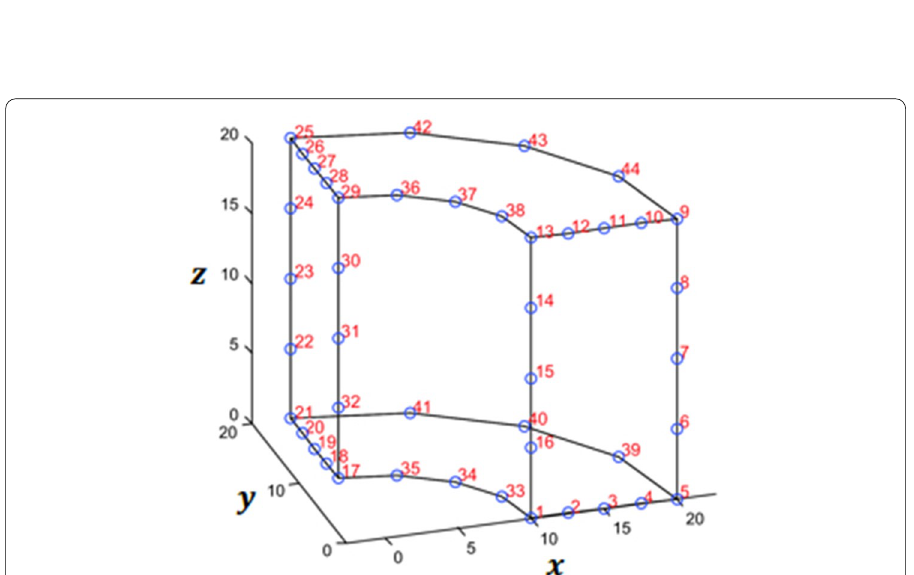
Fig. 12 Boundary element model of a thick hollow cylinder